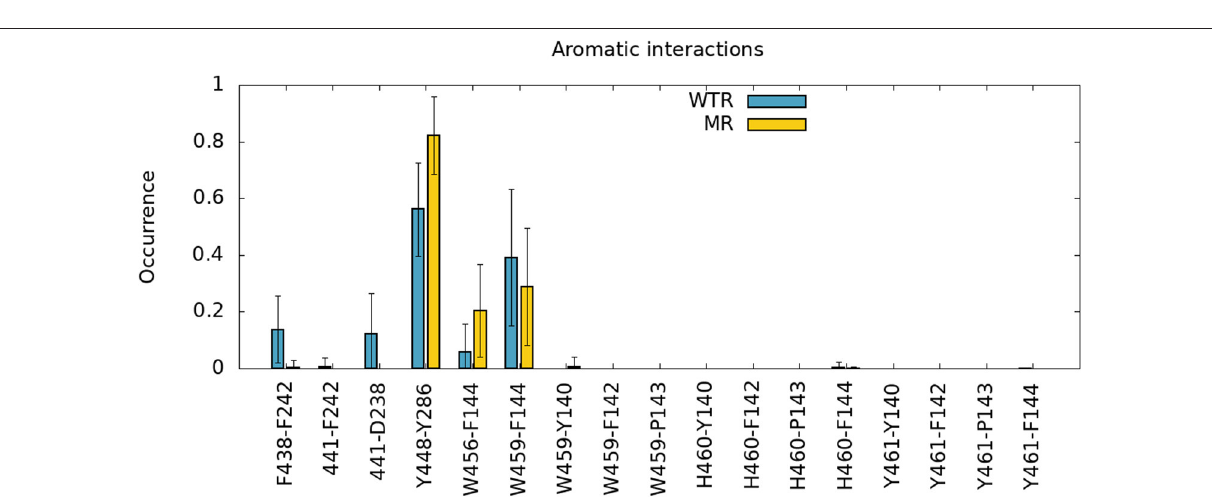
Frontiers in Molecular Biosciences |